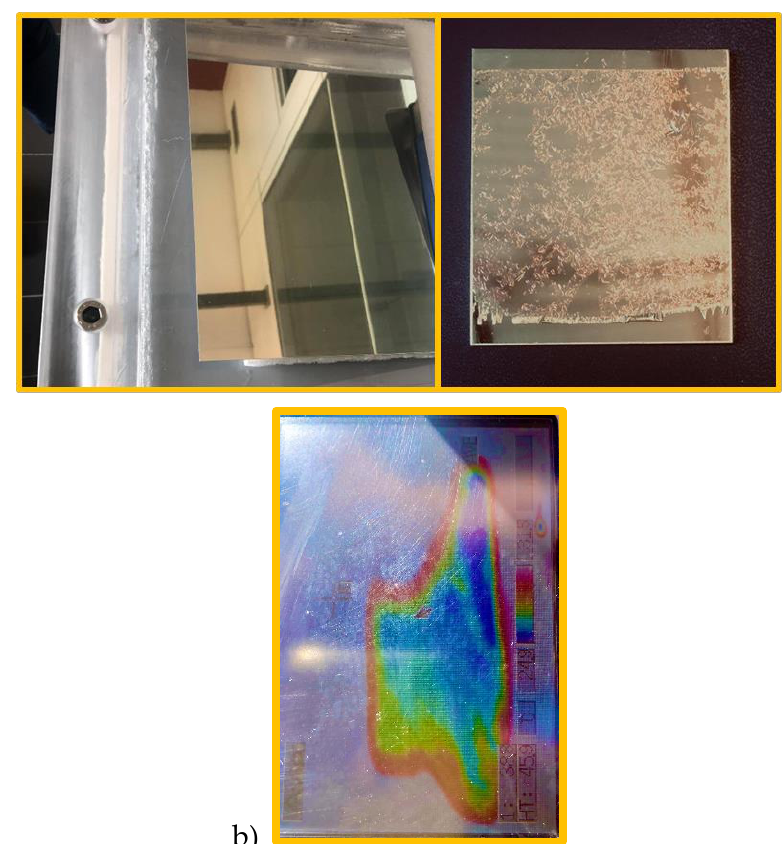
Figure 10. (a) Photos of mirror coatings before and after test. (b) ThermoCamera image during test. Figure 10. ( a ) Photos of mirror coatings before and after test. ( b ) ThermoCamera image during test. Energies 2020 , 13 , x FOR PEER REVIEW